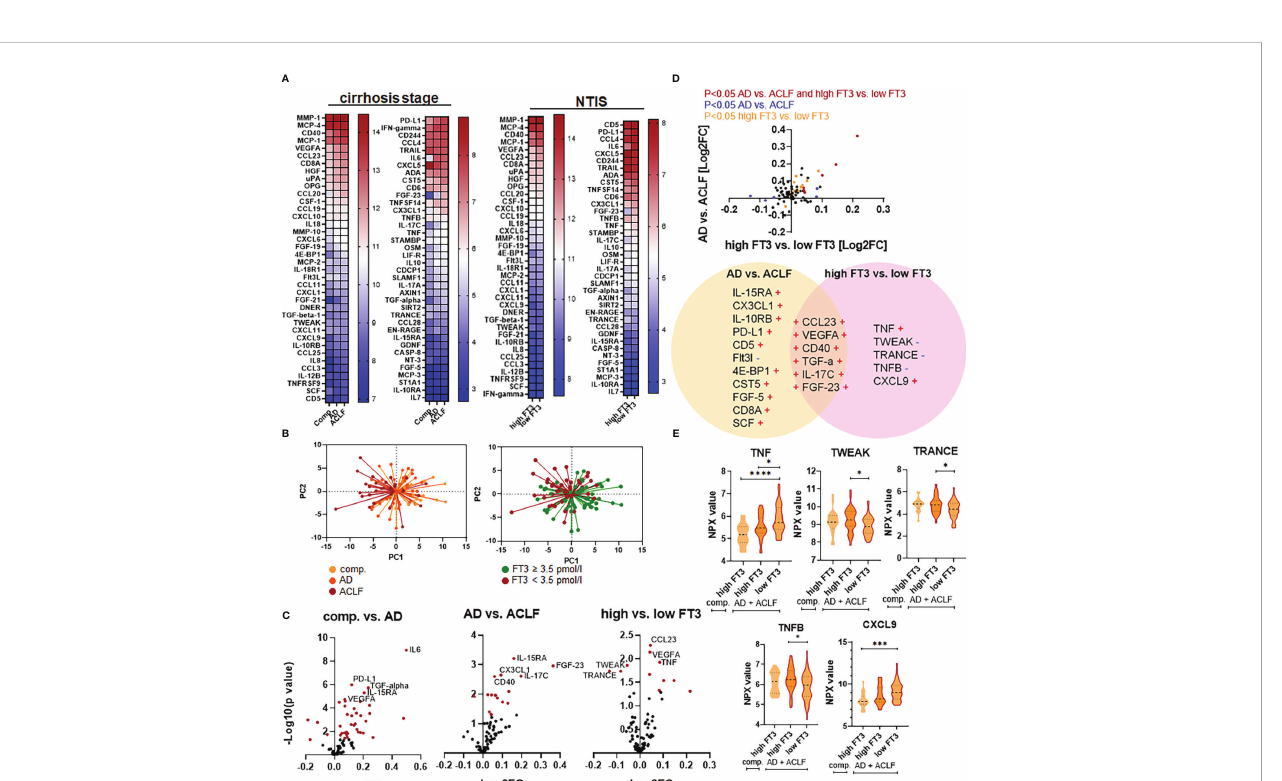
FIGURE 4 Patterns of systemic in fl ammation according to the stage of cirrhosis and according to the presence/absence of non-thyroidal illness syndrome (NTIS). (A) Plasma proteins and in fl ammatory mediators were quanti fi ed by proximity extension analysis assay. Heat-maps of 76 proteins that passed the quality controls are shown according to the stage of cirrhosis (left two panels) and according to the presence/absence of NTIS (right two panels). (B) Principal component analysis of plasma proteins and in fl ammatory mediators are shown of patients with compensated cirrhosis (comp.), acute decompensation (AD), or acute-on-chronic liver failure (ACLF) (left panel) and of patients with AD and ACLF with versus without NTIS (right panel). (C) Volcano blots of plasma proteins and mediators differentially regulated (dots in red mark differentially regulated, i.e. statistically different mediators) in compensated cirrhosis vs. AD, in AD vs. ACLF, and in patients with FT3 concentrations <3.5 pmol/L vs. ≥ 3.5 pmol/L. (D) Plasma proteins and mediators differentially regulated in patients with AD and ACLF only, excluding patients with compensated liver cirrhosis. A volcano blot showing comparisons between patients with AD and ACLF vs. patients with FT3 concentrations <3.5 pmol/L vs. ≥ 3.5 pmol/L is shown in the upper row. Names of the signi fi cantly changed proteins are depicted in the lower row. (E) Violin blots of plasma proteins which are signi fi cantly changed in patients with FT3 concentrations <3.5 pmol/ L vs. ≥ 3.5 pmol/L exclusively, but not in AD vs. ACLF. Graphs show value distribution with median (black dashed line) ± quartiles (colored dashed lines). One-way ANOVA or Kruskal-Wallis test were used as appropriate after Normality Test. *P ≤ 0.05, ***P ≤ 0.001, ****P ≤